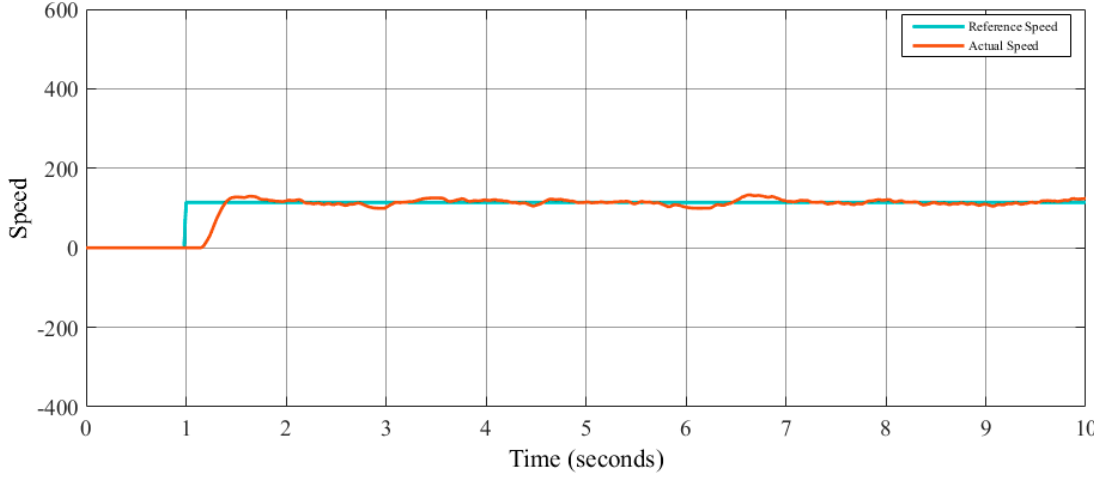
Figure 17. Simulation for PID controller. Table 11. Results for the FLC controller.